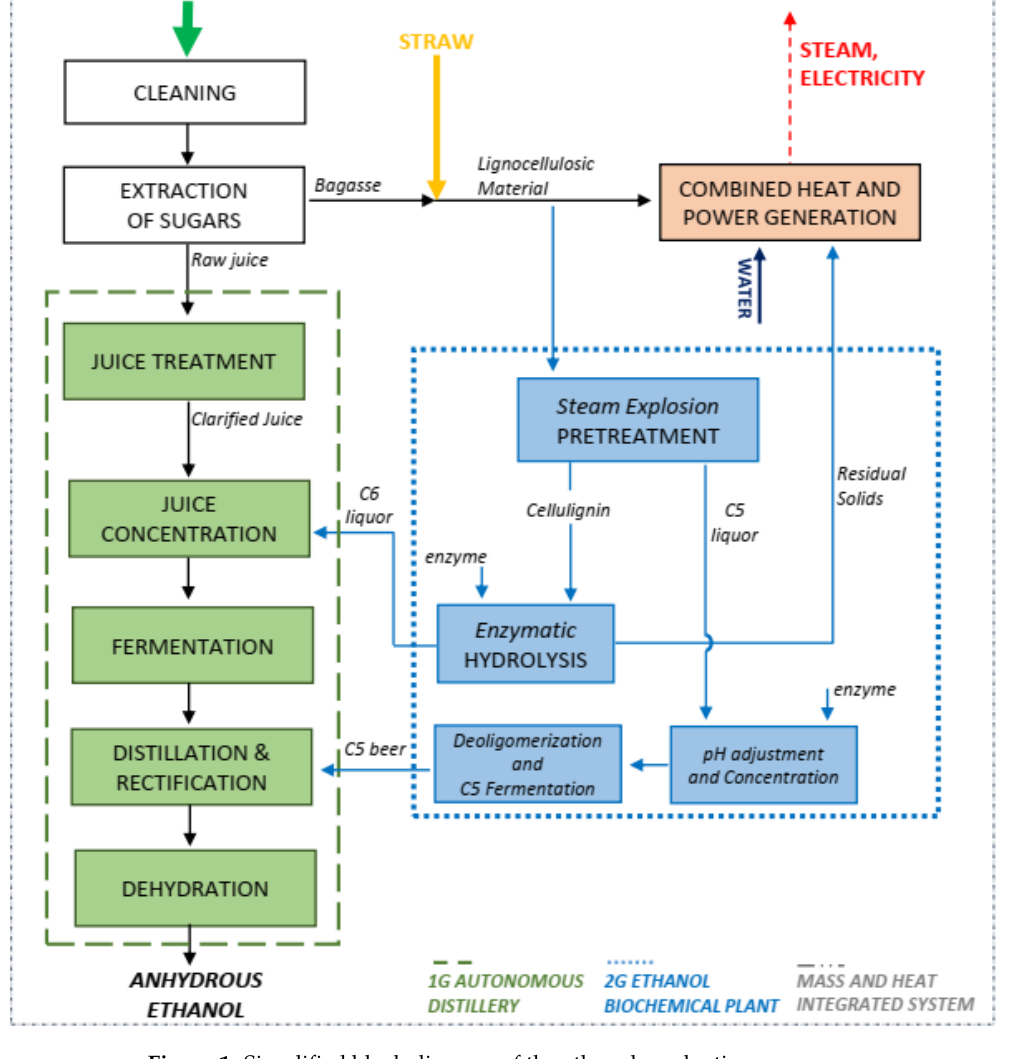
Figure 1. Simplified block diagram of the ethanol production processes.